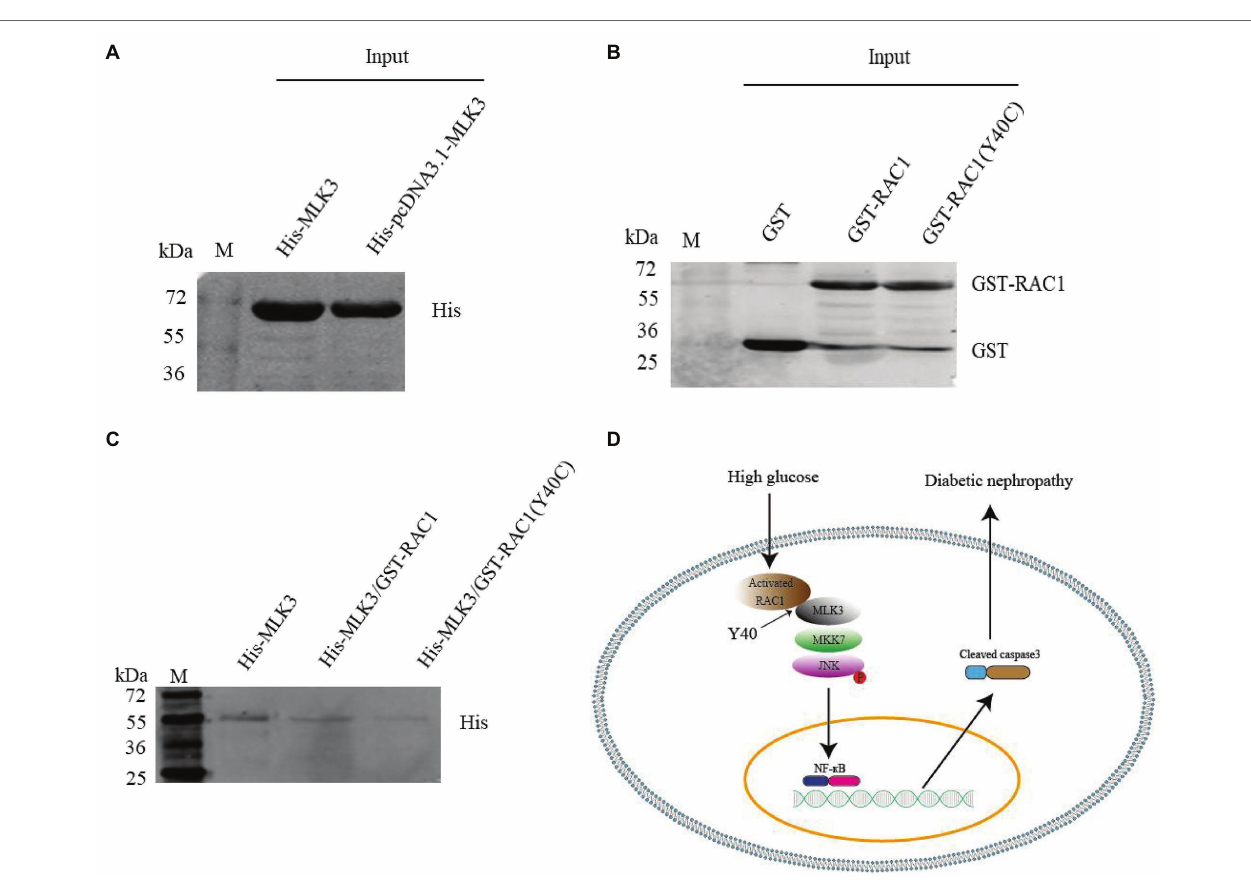
FIGURE 7 | The Y40C mutant inhibits the interaction between RAC1 and MLK3. (A) Pull-down experiment showing the detection of His-tagged MLK3 proteins with an anti-His antibody. (B) Detection of GST, GST-labeled WT RAC1, and GST-labeled Y40C mutant RAC1 proteins using an anti-GST antibody. (C) Interaction of WT RAC1 and Y40C mutant RAC1 with MLK3 tested with an anti-His antibody. (1) Only His-pcDNA3.1-MLK3 as control. (2) GST- PGEX-4 T-1-RAC1 as prey protein and His-pcDNA3.1-MLK3 as bait protein. (3) GST- PGEX-4 T-1-RAC1 (Y40C) as prey protein and His-pcDNA3.1-MLK3 as bait protein. (D) Graphical abstract. RAC1, activated by hyperglycemia, directly binds to MLK3 through RAC1 Y40, facilitating MLK3-MKK7-JNK signaling module assembly and JNK phosphorylation, then increases levels of NF- κ B and cleaved caspase-3, eventually leading to DN.